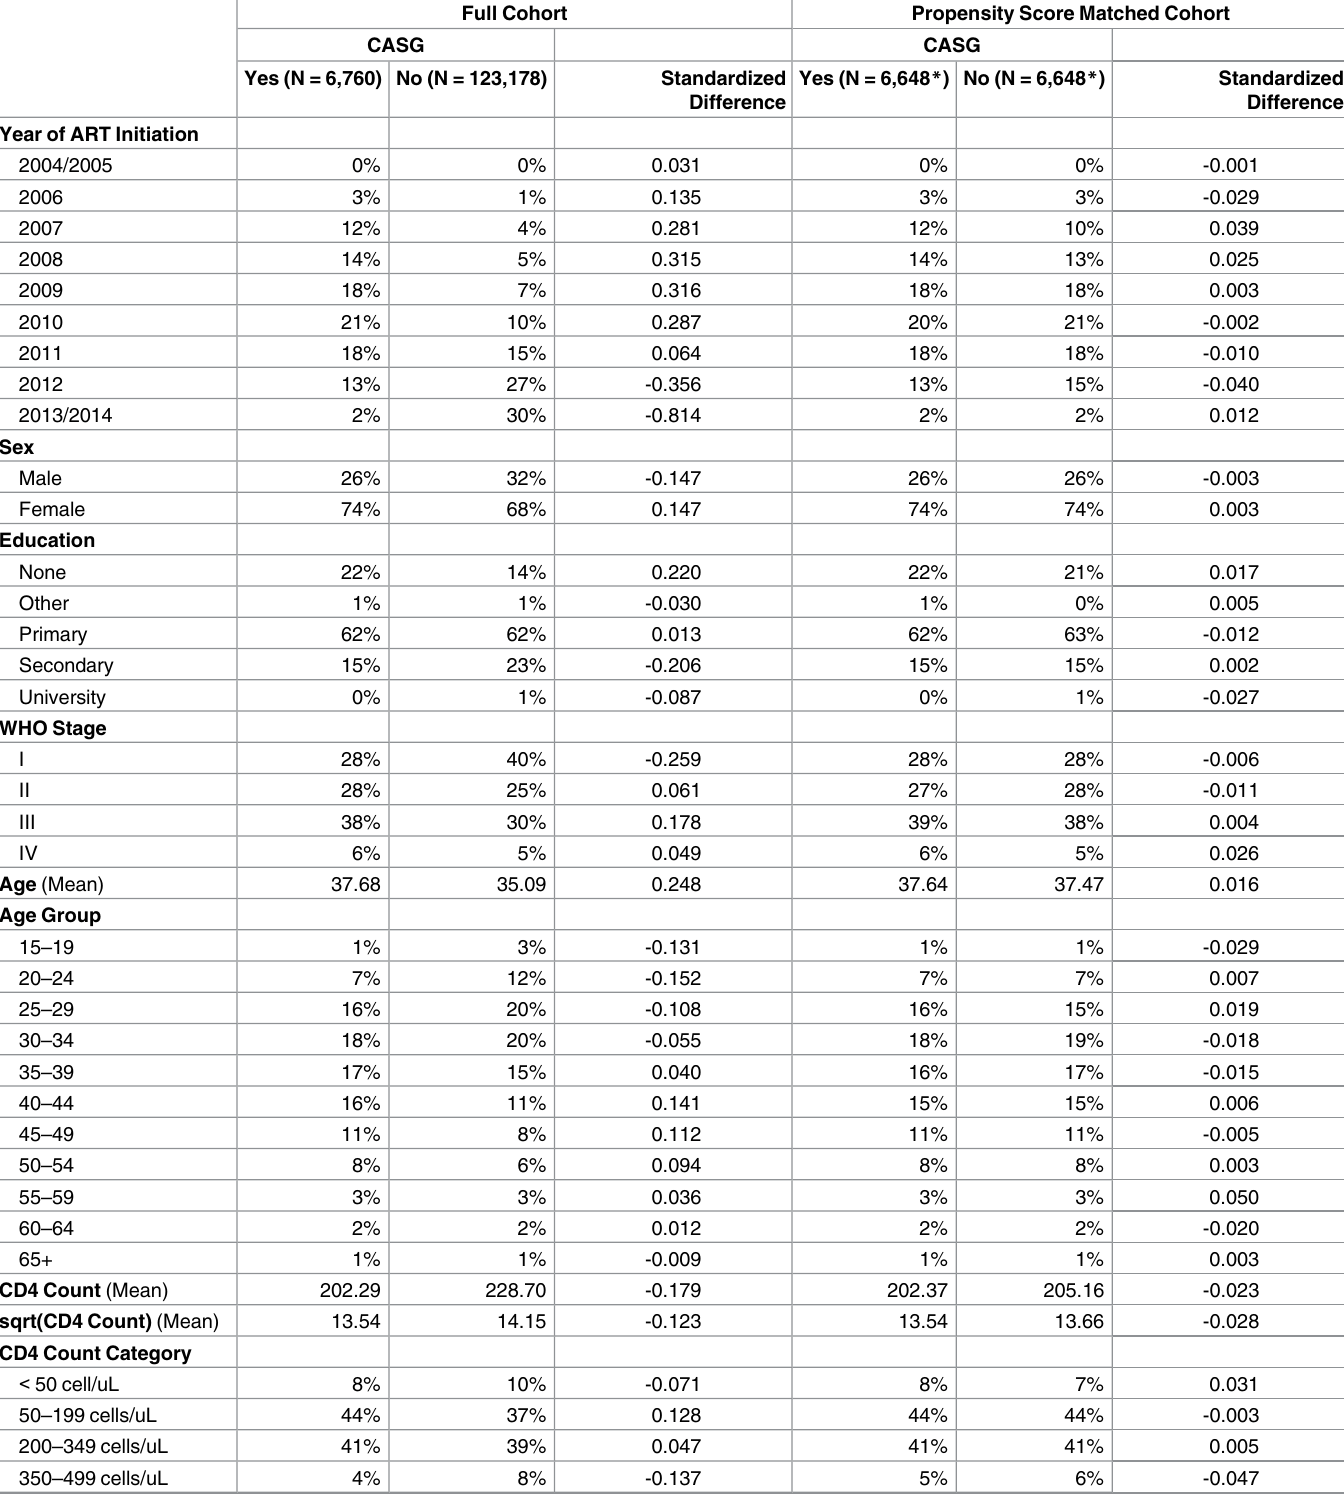
Table 2. Standardized difference between CASG and non-CASG participants in the full and propensity score matched